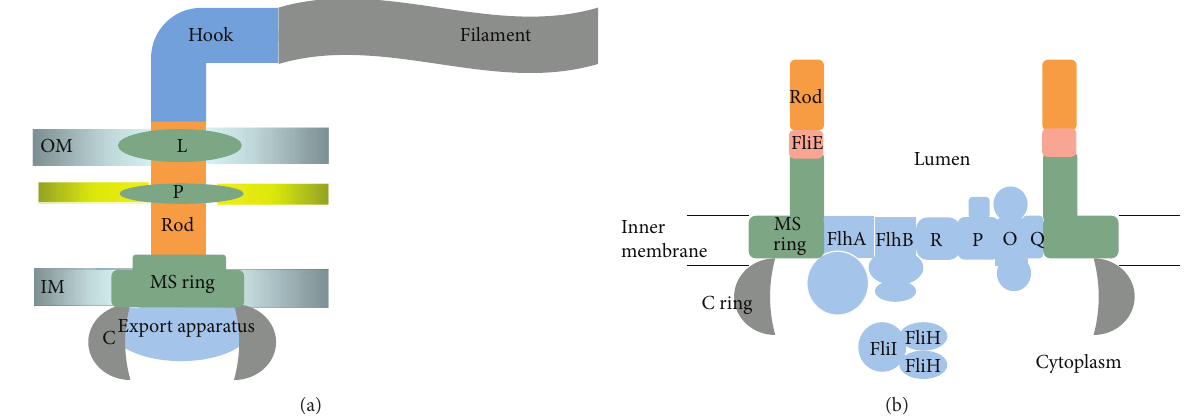
Figure 1: Structure of the flagellum. (a) An overview of the structure of the flagellum in Gram-negative bacteria. Abbreviations are as follows: L ring (L), P ring (P), outer membrane (OM), inner membrane (IM), and C ring (C). (b) Components of the flagellar basal body. Export apparatus proteins are shown in light blue. Abbreviations of the export apparatus proteins are as follows: FliR (R), FliP (P), FliO (O), and FliQ (Q). Details of the organization of the export apparatus proteins are not known, although results from genetic studies suggest associations between FlhA and the MS ring [10], FlhB and FliR [11], and FliO and FliP [12]. FliI is an ATPase which forms a heterotrimer with FliH. These proteins function together with other chaperones (not shown) to shuttle protein substrates to the export pore. Upon docking with a platform formed by the large cytoplasmic domains of FlhA and FlhB, a larger FliI 6 FliH 12 complex is formed. In most bacteria the C ring is composed of three different types of protein subunits (FliG, FliM, and FliN). The C ring in Salmonella contains an estimated 26 copies of FliG, 34 copies of FliM, and ∼ 136 copies of FliN. FliG is closest to the membrane and interacts with the MS ring, while FliN is the most distal to the membrane and FliM is situated between FliG and FliN. The H. pylori C ring contains FliG, FliM, and FliN plus an additional protein subunit (FliY) that shares homology with FliN [13]. Additional information on the bacterial flagellar protein export apparatus can be found in reviews by Minamino et al. [1] and Macnab